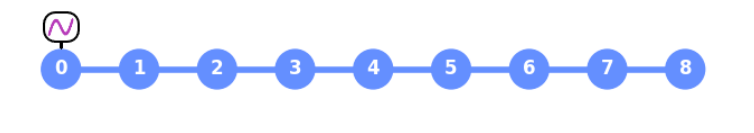
Figure 1: A linear chain of nine qubits with open boundary conditions. The uniform color of the qubits indicate that their lab frequencies are all identical [ ∆ = 0 in Eq. (19) ] . Qubit 0 on the left edge is being driven periodically as in Eq. (20), and the qubits interact with with their nearest neighbors by a “flip-flop” (XY) interaction term as in Eq.